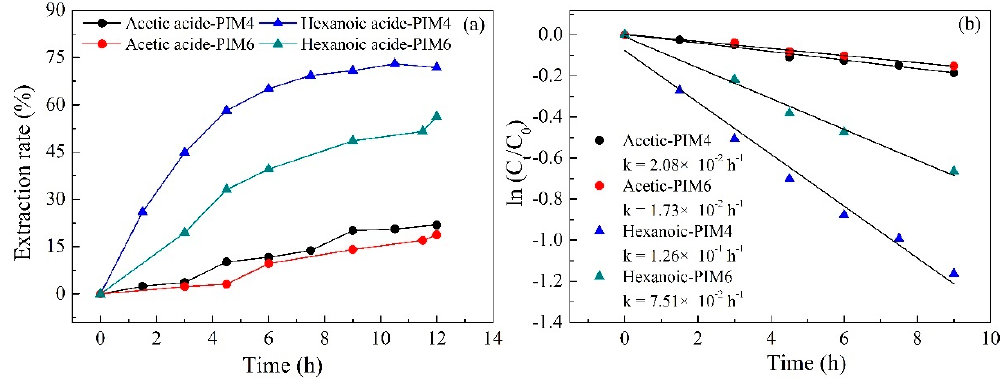
Figure 2. ( a ) Effect of the carrier type (Cyphos IL 101 and Aliquat 336) on the separation of acetic and hexanoic acids from their mixture and ( b ) kinetic plots for the transport of acetic and hexanoic acids across a PIM containing Cyphos IL 101 or Aliquat 336 as the carrier (PIMs: PIM4 and PIM6; Feed solution: 0.01 mol L − 1 acetic acid + 0.01 mol L − 1 hexanoic acid, pH = 6; Stripping solution: 0.1 mol L − 1 HCl).